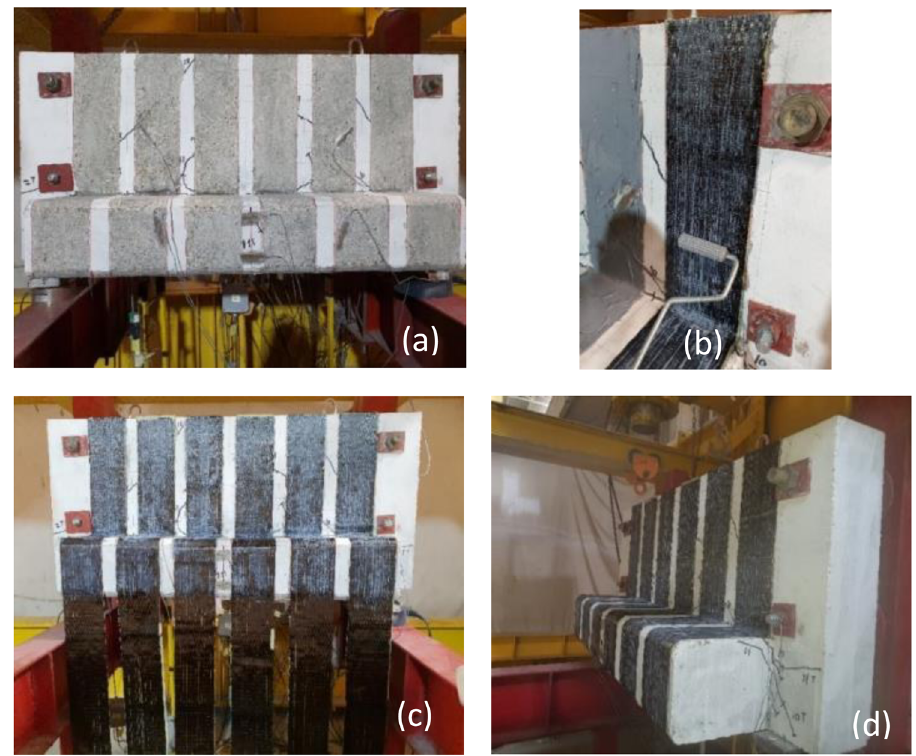
Figure 6: Strengthening procedure: ( a ) grinding of concrete, ( b ) application of CFRP and epoxy, ( c ) front face after application of CFRP, and ( d ) fi nal form after the application of CFRP.